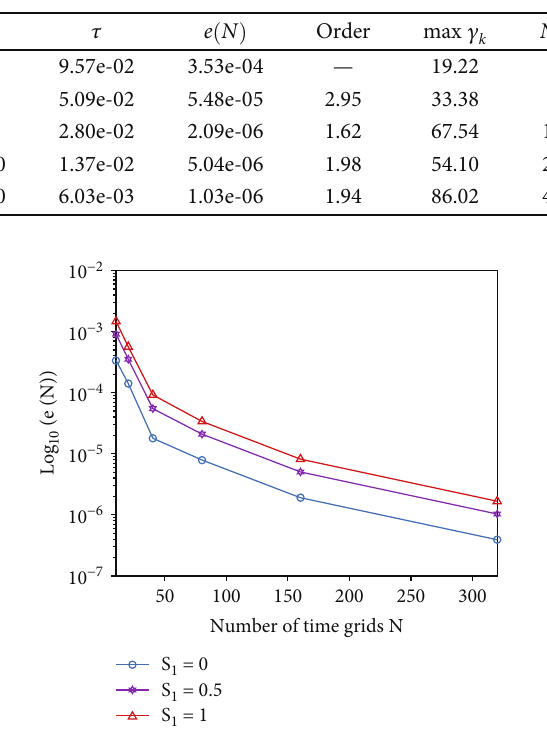
Table 1: Accuracy of BDF2 scheme (6) on random time mesh.